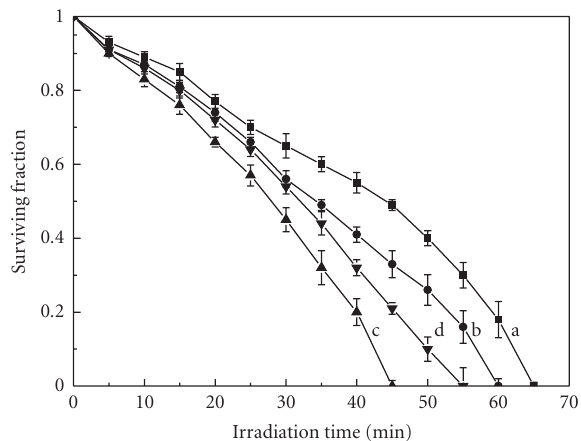
Figure 6: Surviving fraction of LoVo cells under the irradiation of UV light after being incubated in culture mediums: (a) with no TiO 2 , (b) containing 50 μ g/mL TiO 2 , and (c) containing 50 μ g/mL 2 wt% Au / TiO 2 . The wavelength of UV light is 365nm, and the in- tensity is 1.8 mW/cm 2 . Bars represent the region of measured data and the points represent the mean value.